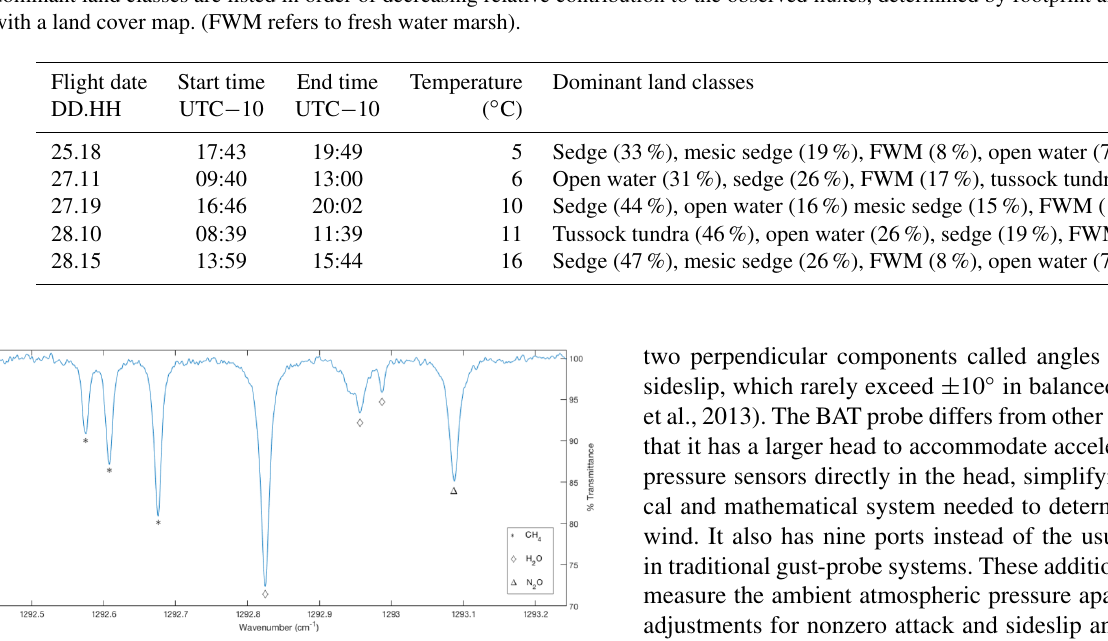
region of the IR instrument, as further discussed in Sect.